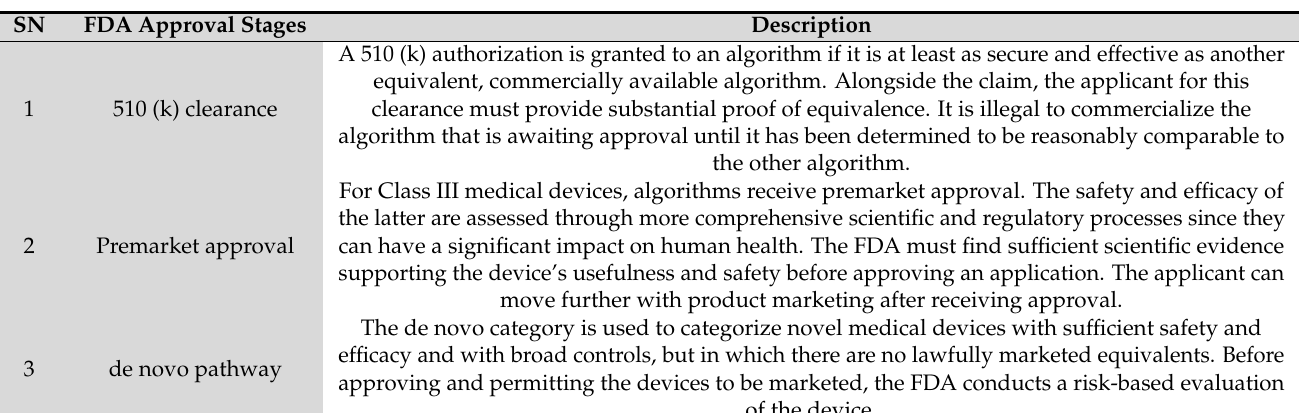
Table 1. Types of Food and drug administration (FDA) approvals for AI/ML-based healthcare technology are described